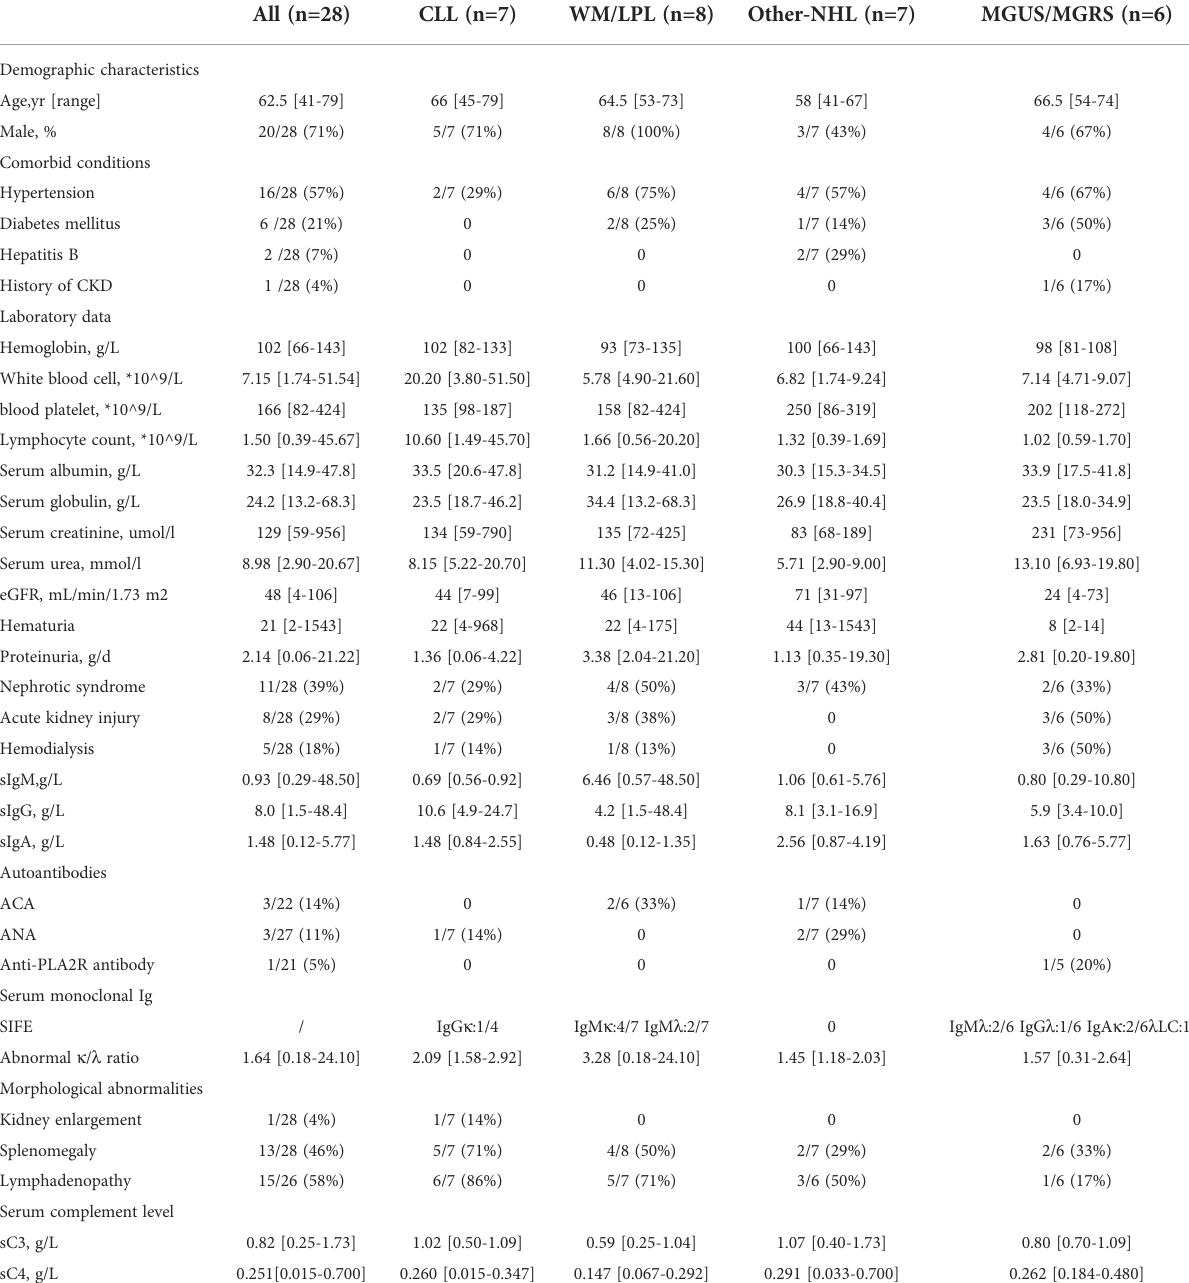
TABLE 1 Baseline and demographic characteristics at the time of kidney biopsy. All